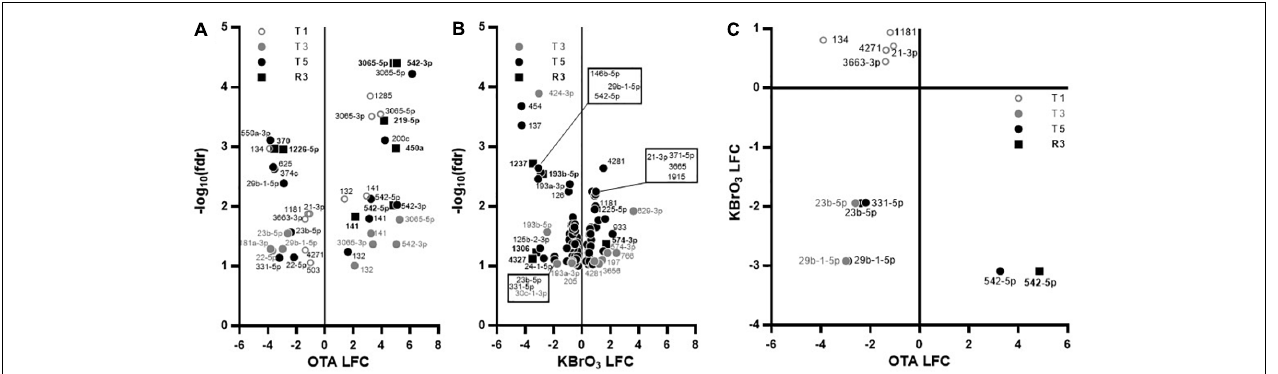
FIGURE 5 | Effects on miRNA expression in RPTEC/TERT1 cells. (A,B): Differentially expressed miRNAs in OTA- (A) and KBrO 3 - (B) treated cells. Significance of change compared to time-matched control was set to p ≤ 0.1 based on false discovery rate (fdr) and plotted as log 2 fold change (LFC) vs –log 10 (fdr). There was no significant change at T1 in KBrO 3 -treated cells. (C): Relative expression of miRNAs significantly impacted by KBrO 3 at T5 and by OTA at the indicated time point, regardless of the direction. Changes occurring with one chemical only are not